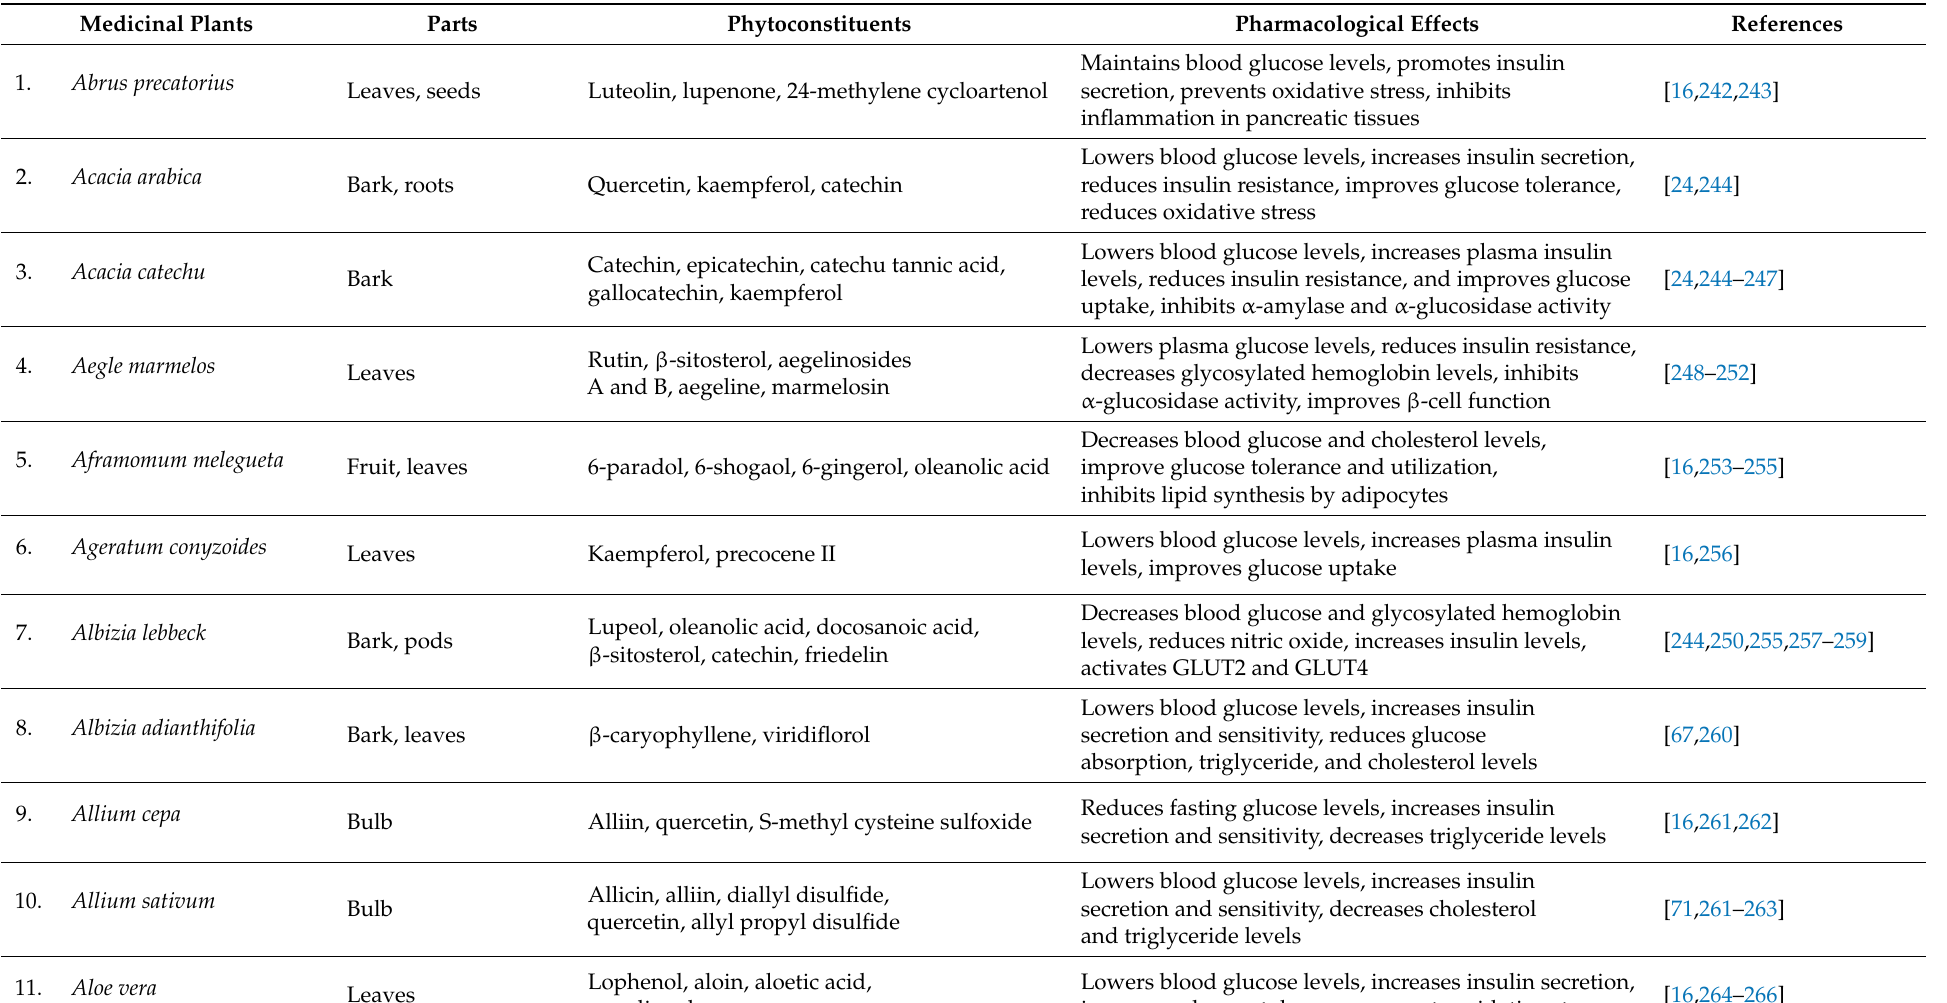
Table 2. Phytoconstituents of antidiabetic medicinal plants and their pharmacological